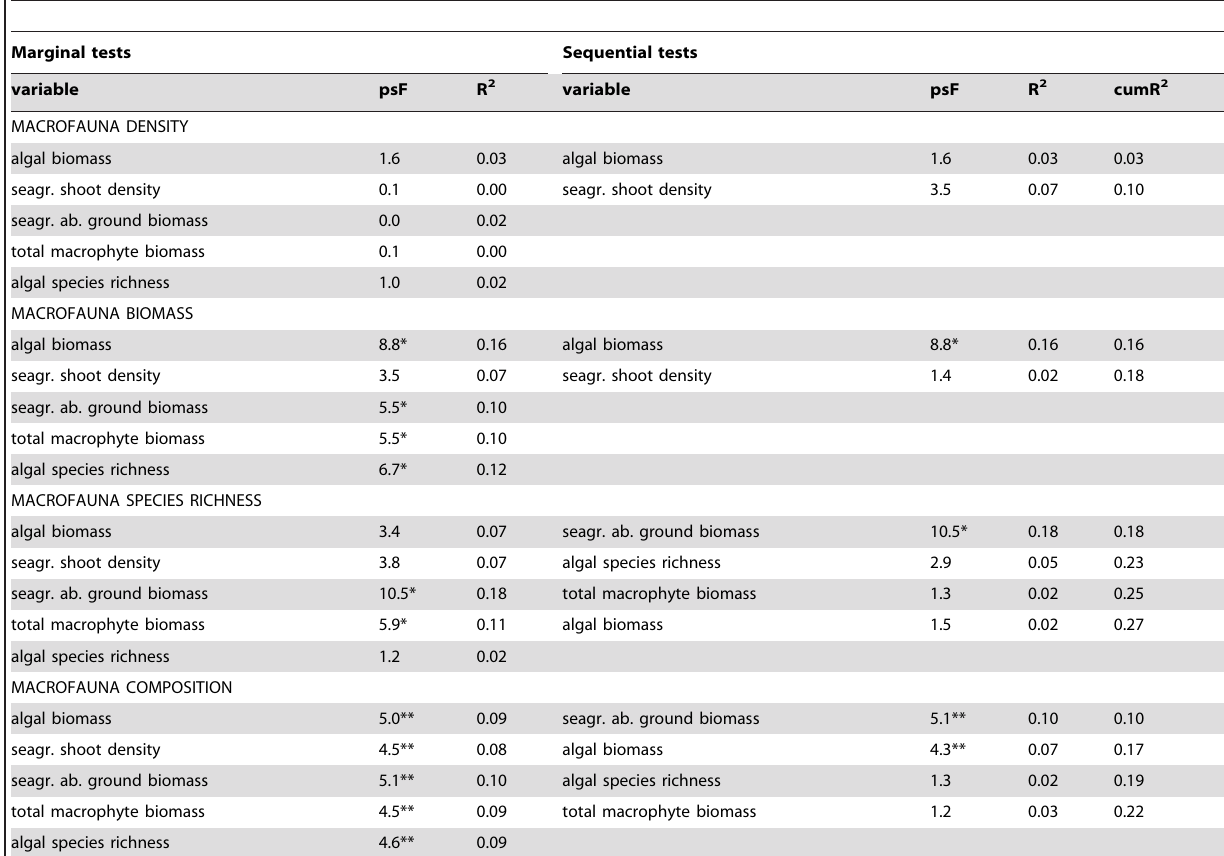
Table 4. Results of DISTLM procedure for fitting macrophyte cover biometrics to macrobenthic community characteristics for samples collected in vegetated sediments.